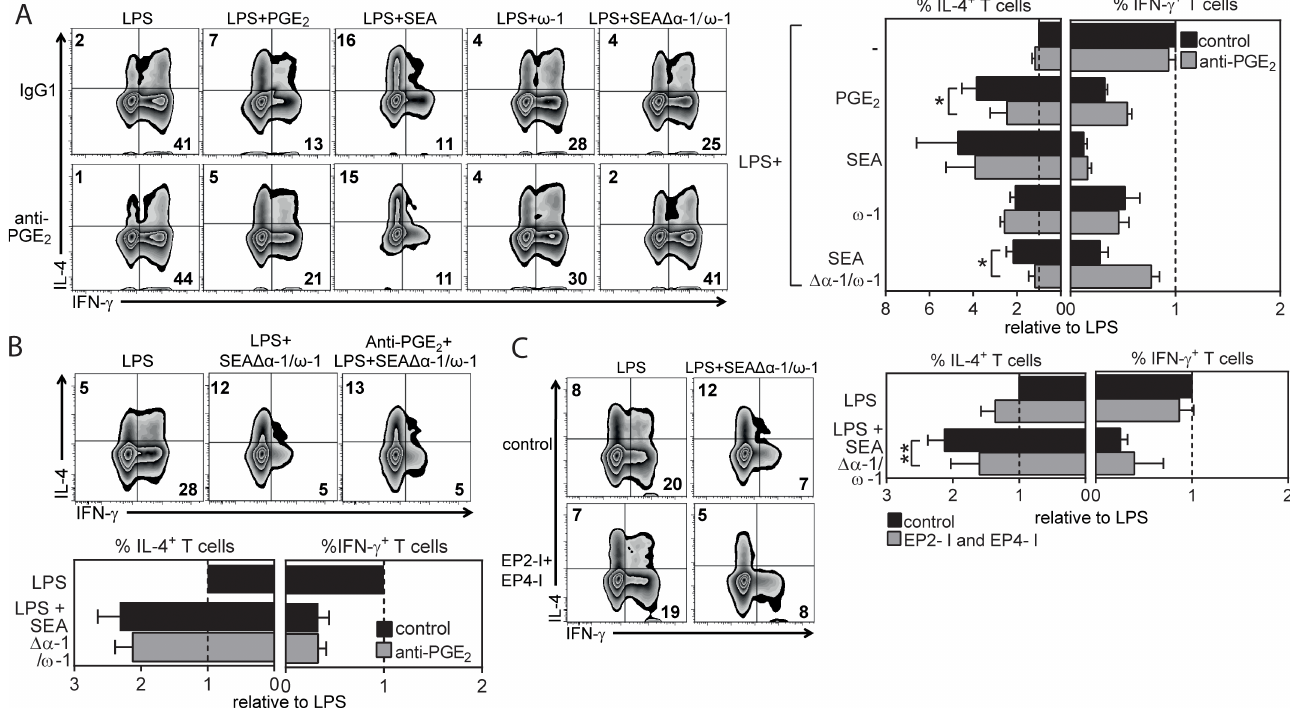
Fig 2. ω-1–independent Th2 polarization by SEA is dependent on PGE 2 synthesis by moDCs. (A–C) T-cell polarization assay as described in Fig 1B. (A) Neutralizing anti-PGE 2 antibody was added during stimulation of moDCs with indicated reagents or (B) during DC–T cell coculture. (C) EP2 and EP4 receptor inhibitors (EP2-I and EP4-I) were added during stimulation of moDCs with indicated stimuli. (A–C) Left: representative flow cytometry plots are shown of intracellular staining of CD4 + T cells for IL-4 and IFN- γ . Numbers in plots represent frequencies of cells in indicated quadrants. Right: these data were used to calculate the fold change in frequency of IL-4 + and IFN- γ + T cells polarized by moDCs stimulated with indicated stimuli relative to the cytokine production by T cells polarized by LPS-stimulated moDCs, for which the values were set to 1. Bars represent mean ± SEM of at least 4 independent experiments. Significance was calculated based on the ratio of IL-4 over IFN- γ between conditions. (cid:3) P < 0.05 and (cid:3)(cid:3) P < 0.01 for significantly different from control conditions based on paired analysis (paired Student t test). Underlying data can be found in S1 Data. ω-1, omega-1; CD4, cluster of differentiation 4; EP2, prostaglandin E 2 receptor 2; IL-4, interleukin 4; IFN γ , interferon γ ; LPS, lipopolysaccharide; moDC, monocyte-derived DC; PGE 2 , prostaglandin E 2 ; SEA, soluble egg antigen; Th2, T helper 2.